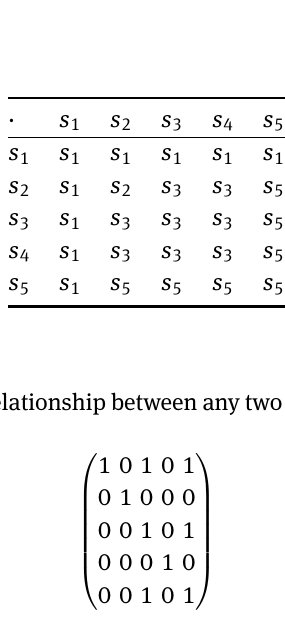
Table 1: The multiplication table on